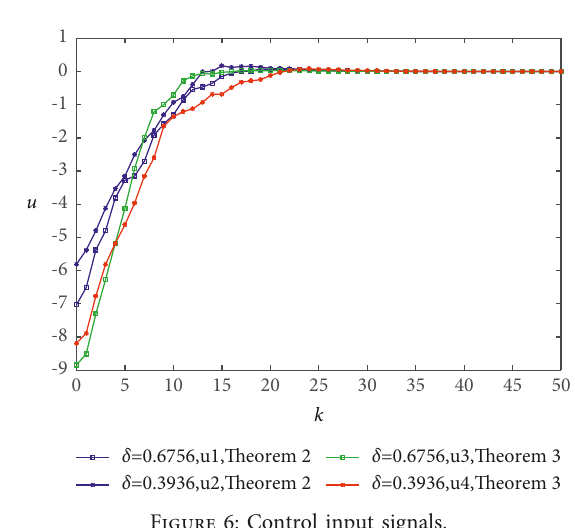
Figure 5: c ( k ) trajectory.